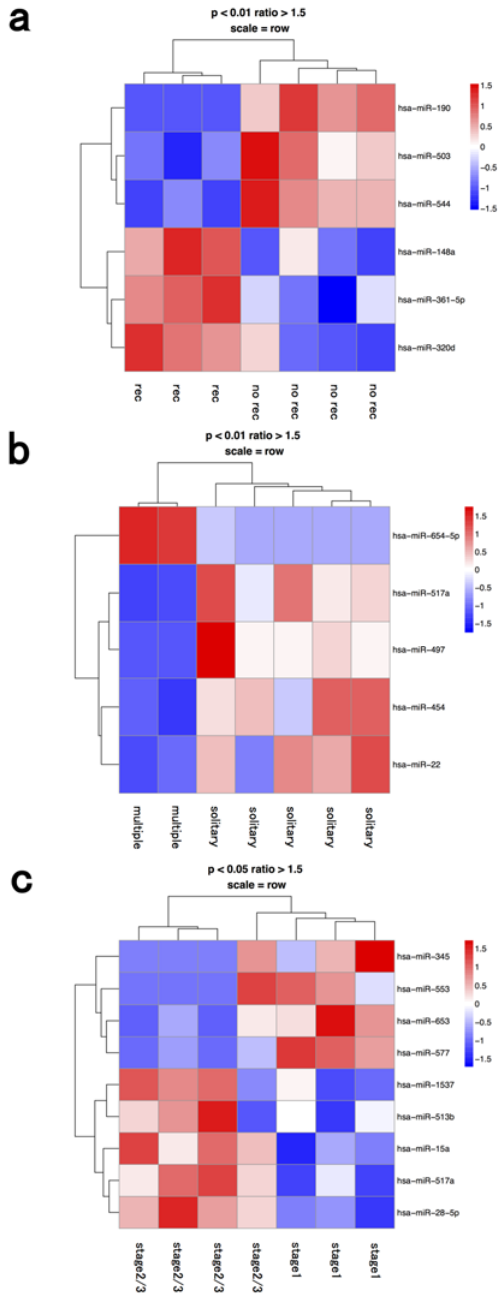
Figure 2. Hierarchical clustering analysis of microRNAs of lymphocyte fraction in seven patients with hepatocellular carcinoma. Heat map of the miRNA profile in macrophages from hepatocellular carcinoma patients with ( a ) recurrence ( n = 3) and no recurrence ( n = 4); ( b ) solitary ( n = 5) and multiple tumors ( n = 2); ( c ) stage 1 ( n = 3) and ≥ stage 2 ( n = 4). Cluster analysis showed six, five, and nine miRNAs that were significantly differentially expressed between the two groups with a >1.50-fold change, respectively. Colors range from blue to red, corresponding to low to high expression, respectively. p values <0.01 or <0.05, unpaired t test. rec: